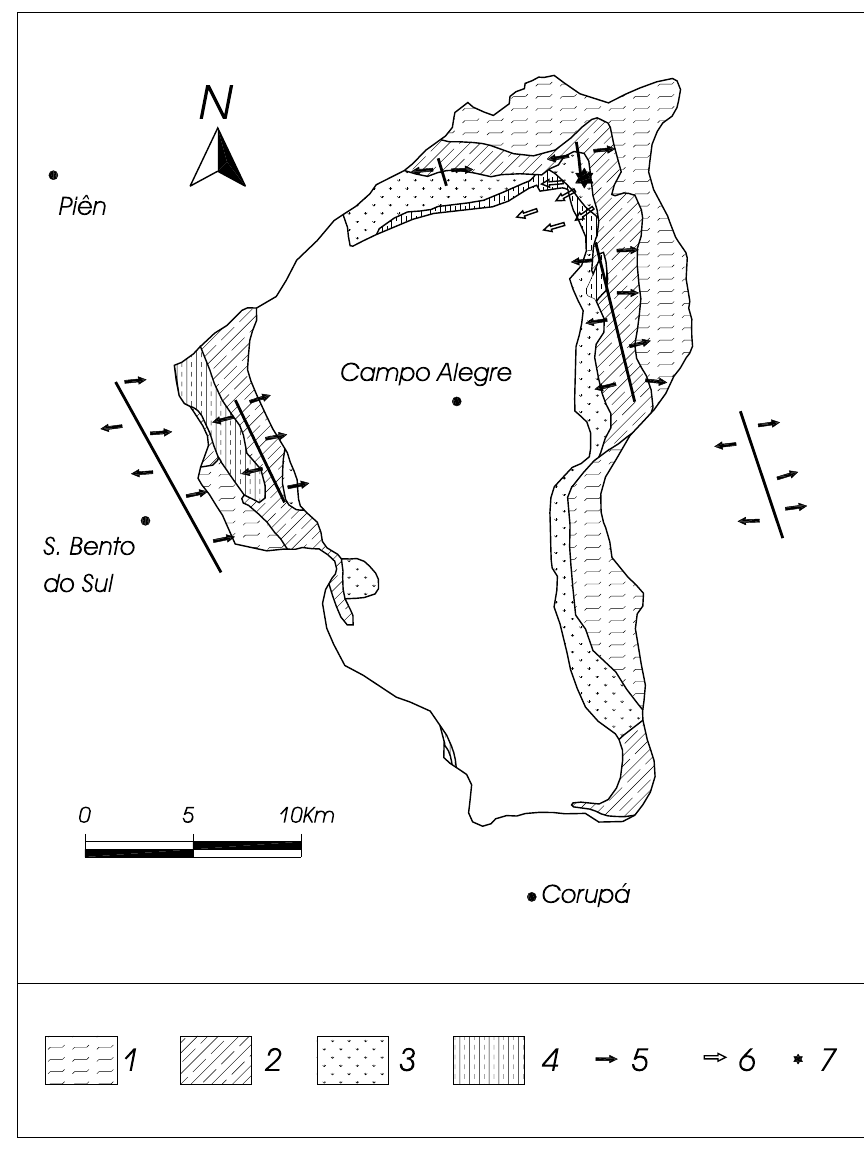
Fig. 4 – Paleogeography of the first phase of the volcanic stage: 1)- Rio Negrinho pelites; 2)- Rio Negrinho basalts; 3)- Rio Negrinho trachytes; 4)-Avenca Grande ignimbrites; 5)- basaltic flow direc- tions; 6)- ignimbrite flow direction; 7)- possible volcanic center of the Avenca Grande ignimbrites.